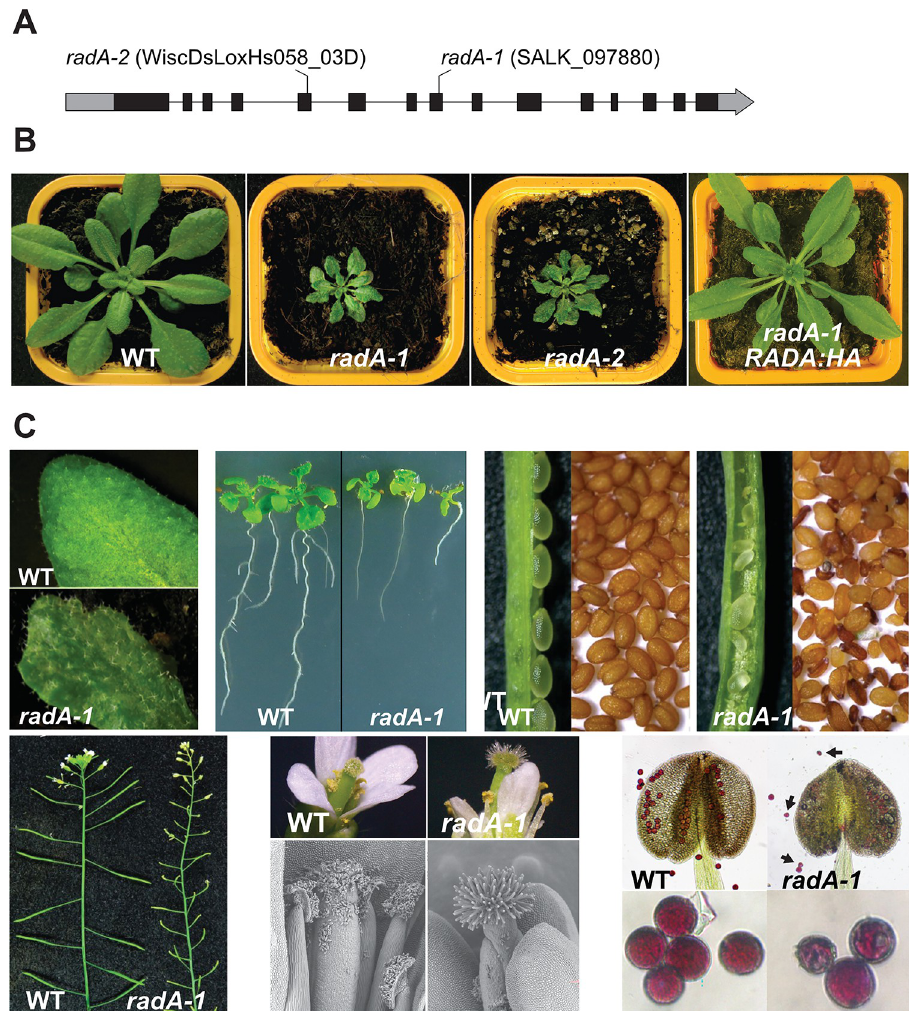
Fig 5. Arabidopsis radA mutants and phenotypes. ( A ) Schematic representation of the Arabidopsis RADA gene. Coding sequences are in black and 5’- and 3’-UTRs are in gray. The position of the T-DNA insertions in radA mutant lines is shown. ( B ) radA plants show severe growth retardation, with distorted leaves presenting chlorotic sectors. These phenotypes can be complemented by expression of HA-tagged RADA (RADA:HA) under control of the endogenous RADA promoter. ( C ) Detail of mutant phenotypes as compared to WT, showing deformed leaves, root shortening and flower stems with very small radA siliques that mostly contain aborted seeds. Most of the few seeds produced are non-viable. Flowers are also deformed, and visible and SEM images show that in radA no pollen binds to the papillae of the stigma. Alexander staining of pollen in radA anthers as compared to WT shows little pollen production and an abundance of small and aberrant pollen grains (indicated by